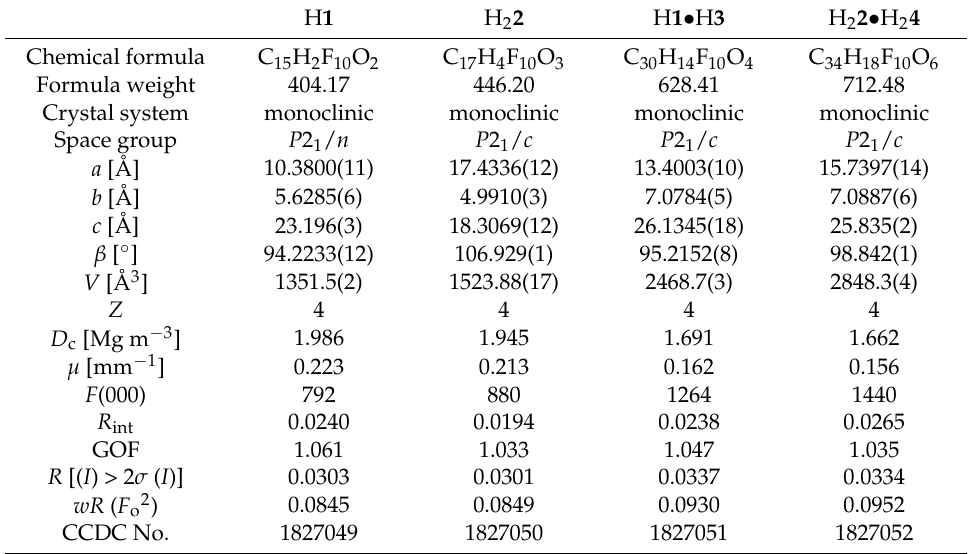
Table 1. Crystal data and structure refinement for H 1 , H 2 2 , H 1 • H 3 , and H 2 2 • H 2 4